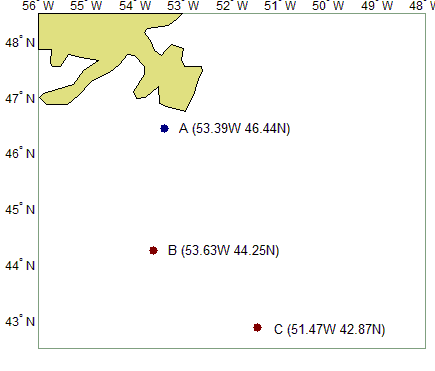
Figure 1. Geographic location of the three buoys for comparison with reconstructed wind